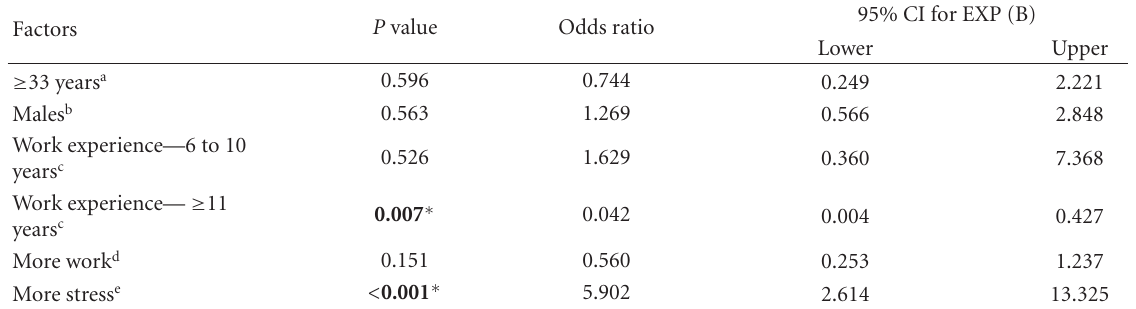
Table 3: Diurnal Bruxism and independent factors among IT professionals ( N = 147). Multiple logistic regression analyses giving odds ratio and 95% confidence